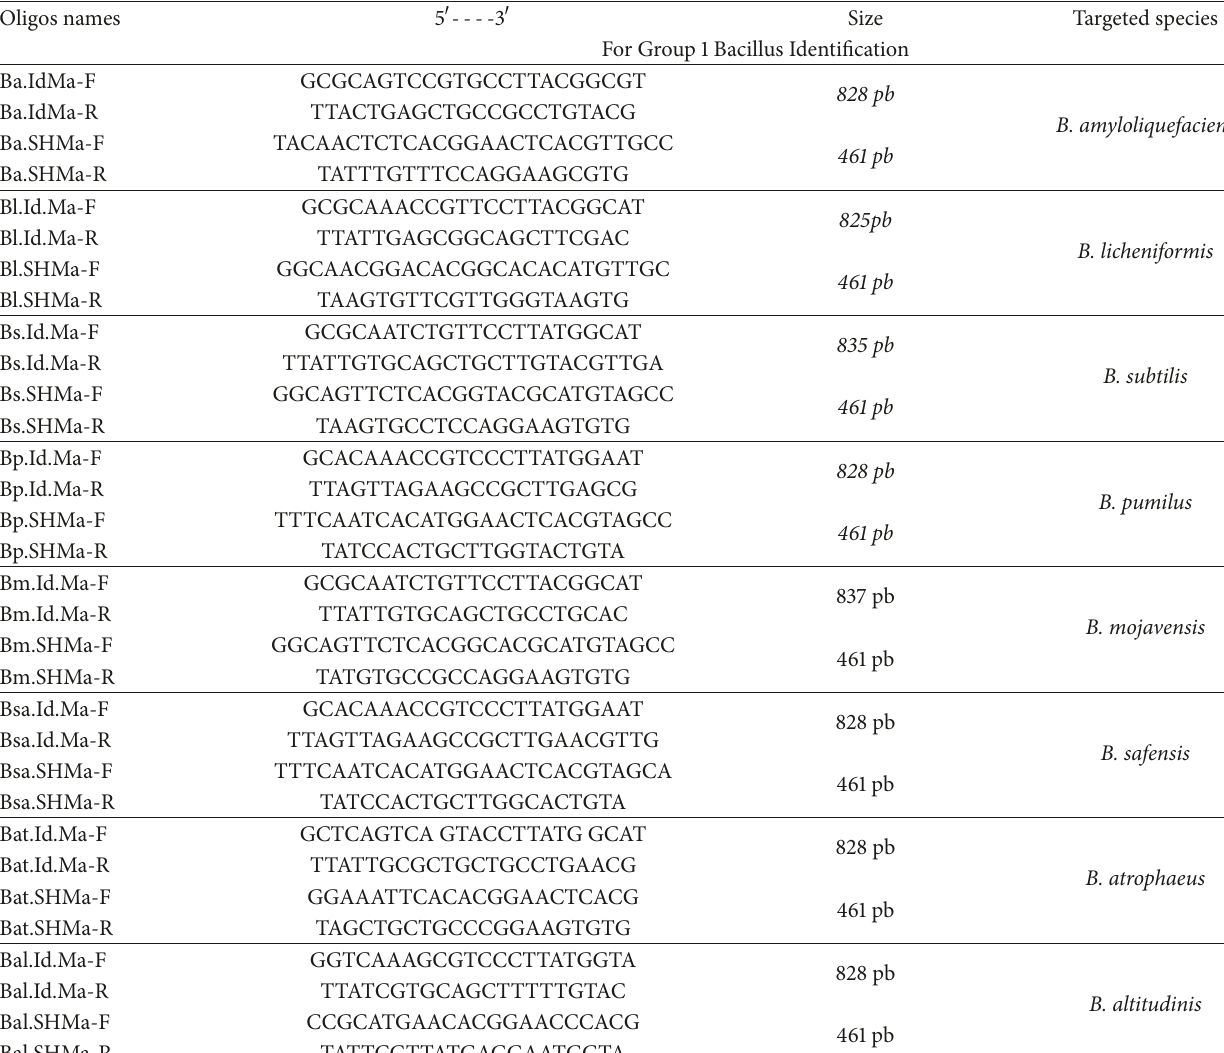
Table 1: Primers used in this study in terms of identification of